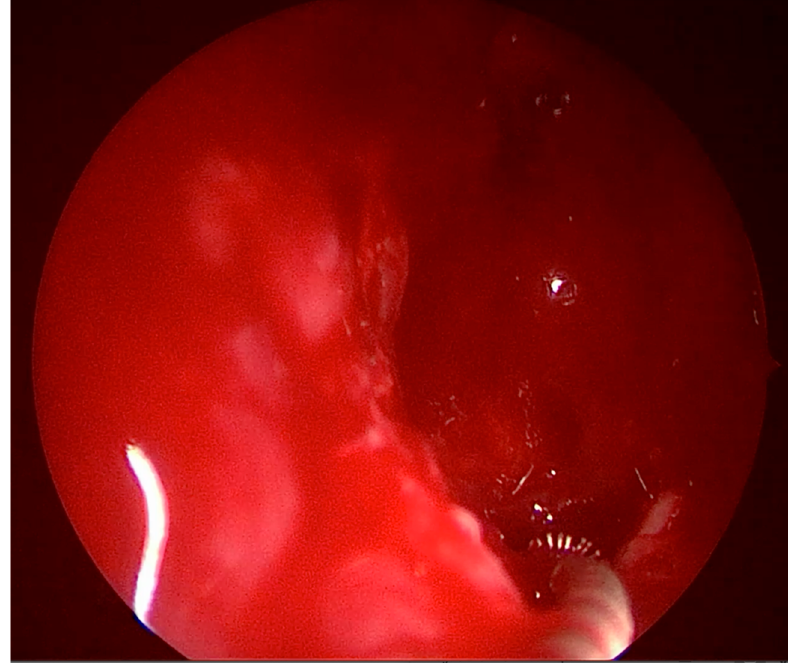
Figure 4. The stylet being inserted under direct supervision into the lateral recess.